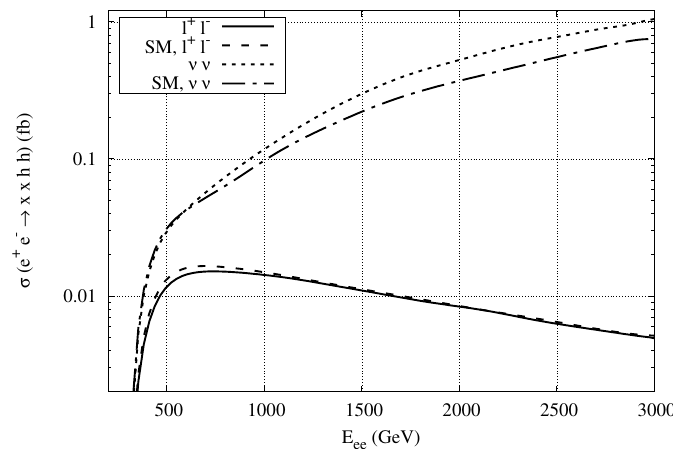
Figure 6 . Statistical Sensitivity for γγ → hh in MCHM4 and MCHM5.